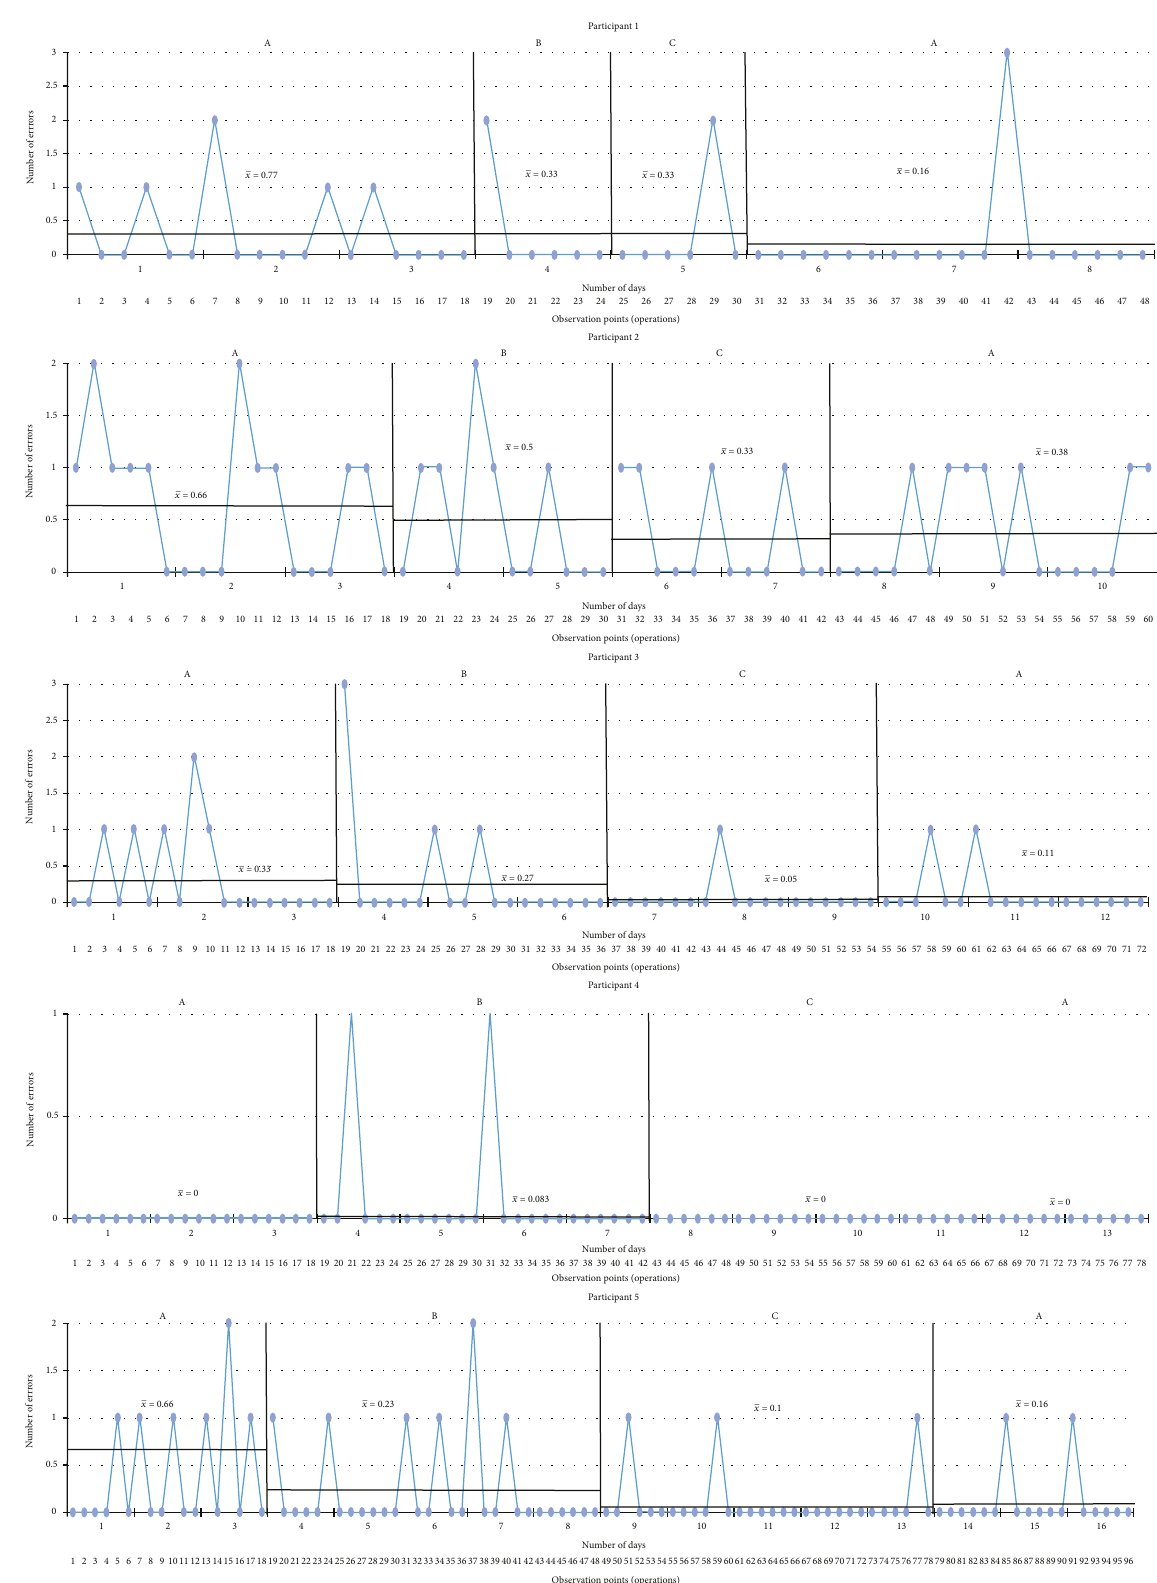
Figure 6: Subtraction question. A: baseline; B: sham tDCS; C: tDCS; x -axis: observation points in number of tasks performed within days; y -axis: number of errors. Scores are shown, along with black lines marking the average of each